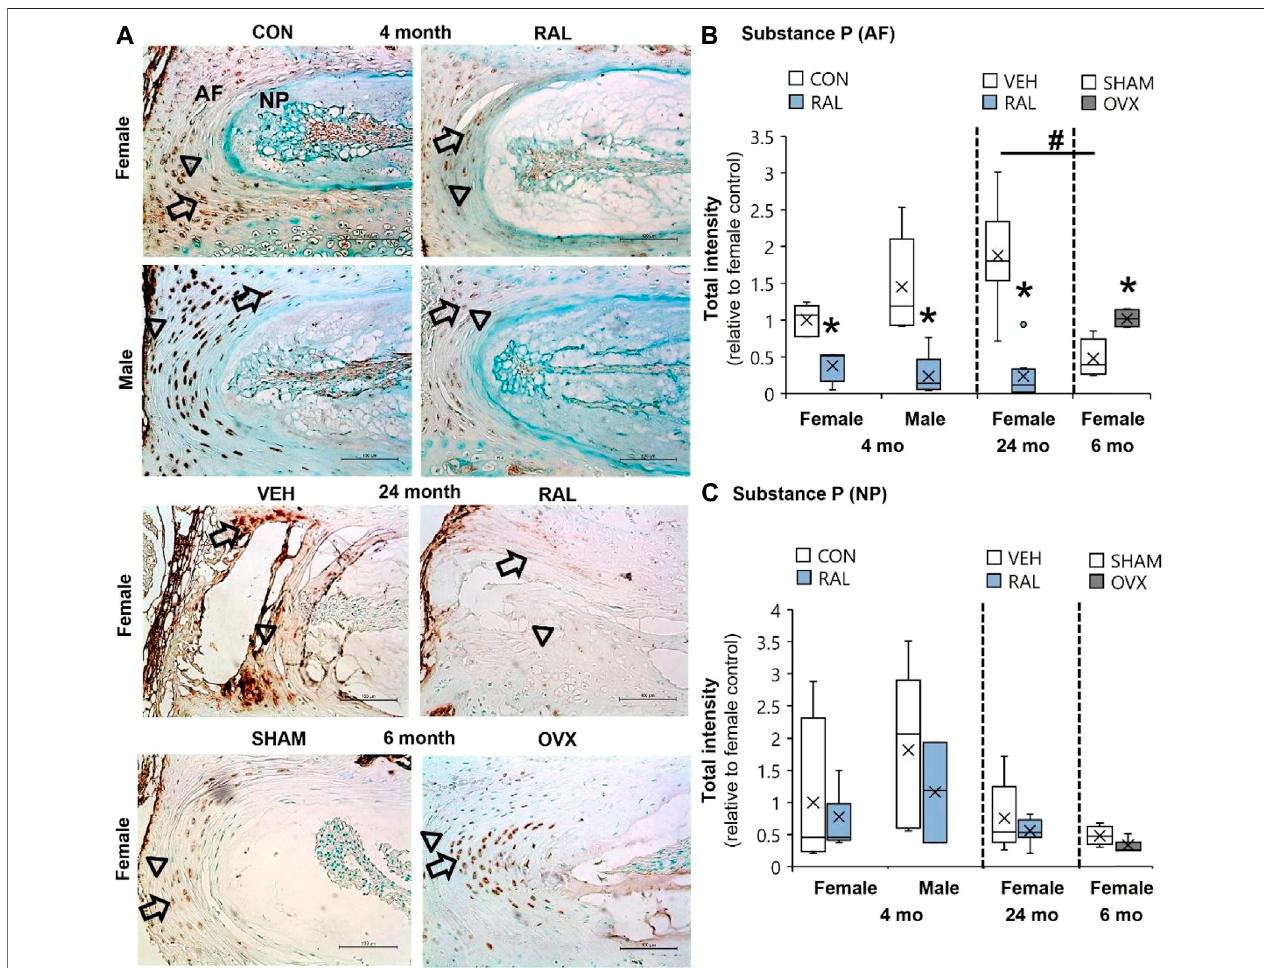
FIGURE4| SPexpressionintheAFwaselevatedbyagingandOVXandsuppressedbyraloxifene. (A) SubstanceP(SP)immunostaining(arrow:presenceofstain, arrowhead: absence of stain) in the (B) AF and (C) NP of young-adult (4 months), OVX (6 months), and old (24 months) mice. Data are represented as box plots with mean marked as cross (x), 25/75% deviation lines, and maximum/minimum whiskers. *: Control (CON, n = 5/sex/group) vs. raloxifene (RAL), SHAM ( n = 4 – 5/group) vs. ovariectomized (OVX), vehicle (VEH, n = 8/group) vs. RAL; # : aging effect (4 months vs. 6 months vs. 24 months), p < 0.05. AF, annulus fi brosus; and NP, nucleus pulposus. Scale: 100 μ